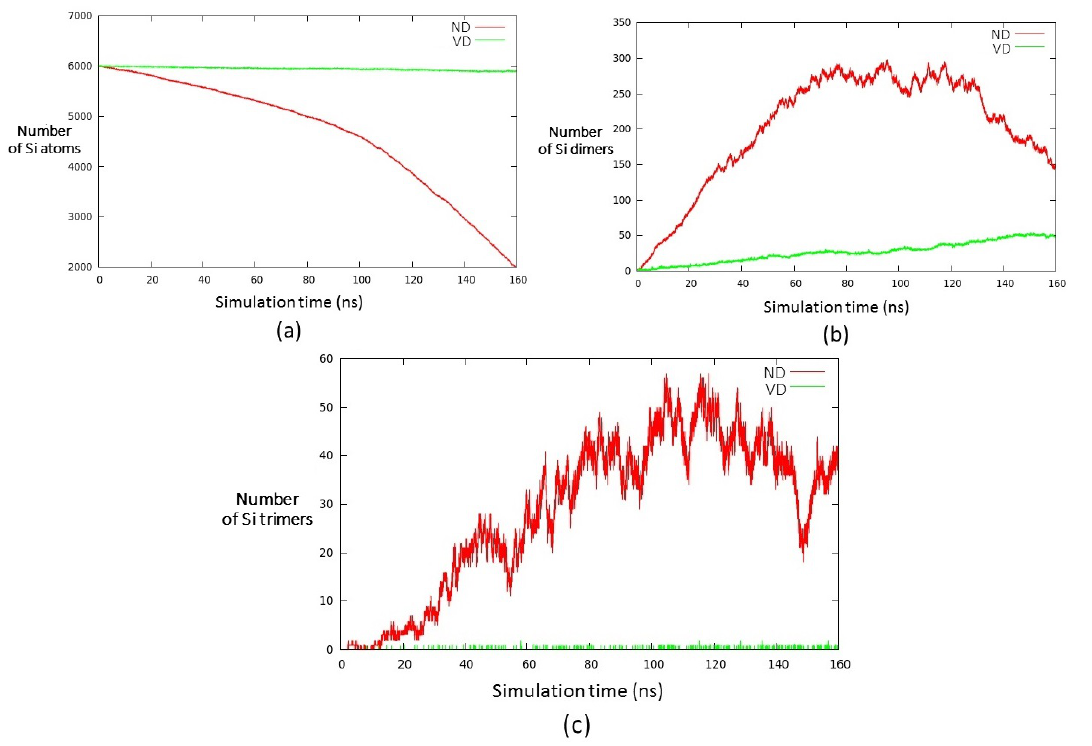
Figure 5. Number of ( a ) unreacted Si atoms; ( b ) dimers; and ( c ) trimers as a function of time at T = 2000 K. The results from the ND and VD FFs are shown in red and green,